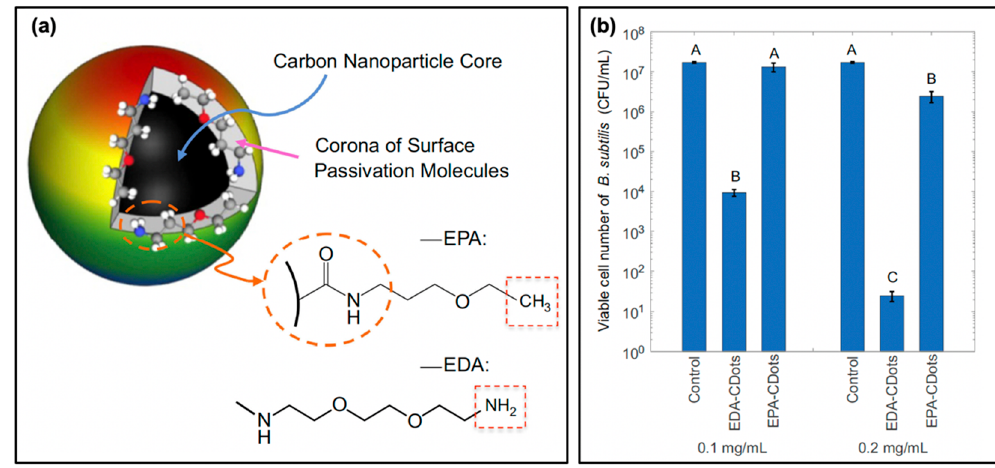
Figure 7. Surface charge effects on antimicrobial activity. ( a ) Schematic showing the surface passivation agents used to tune the surface charge of carbon nanodots, whereby 2,2-(ethylenedioxy)bis-(ethylamine) (EDA) confers a positive charge and 3-ethoxypropylamine (EPA) a neutral charge at pH 7.4. ( b ) Viability of Bacillus subtilis cells following photodynamic treatment with EDA- and EPA-conjugated carbon dots (EDA / EPA-CDots). The control consists of the light-exposed samples in the absence of carbon dot treatment. Statistical di ff erence is indicated by the letters (A–C, p < 0.05); data with the same letter label have no statistical di ff erence. For additional details regarding the reported studies, the reader is referred to Table 1 of the main text. Permissions : ( a , b ) Adapted from Reference [21]. Open access.